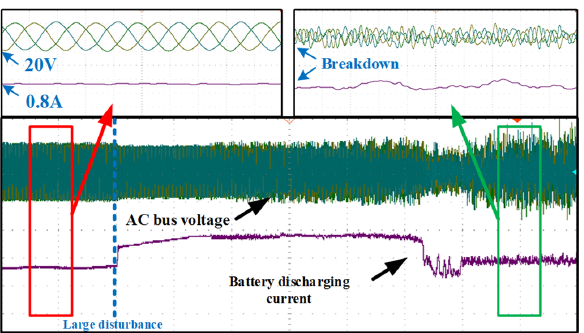
Figure 20. The curves of AC bus voltages and battery discharging current (Group B).